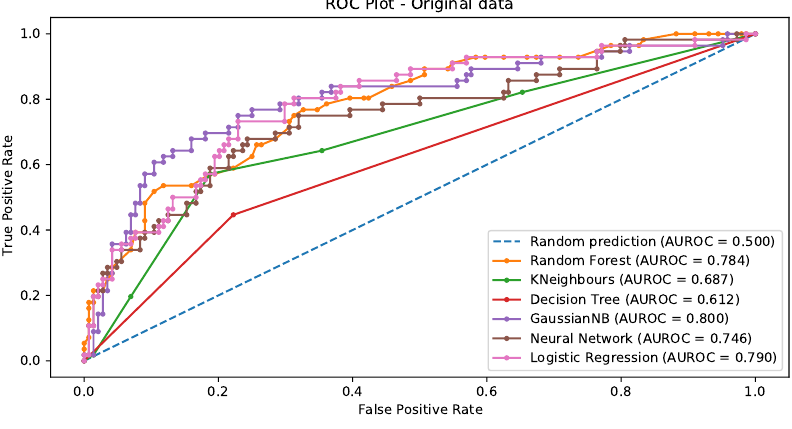
Figure 11. Imbalanced data.